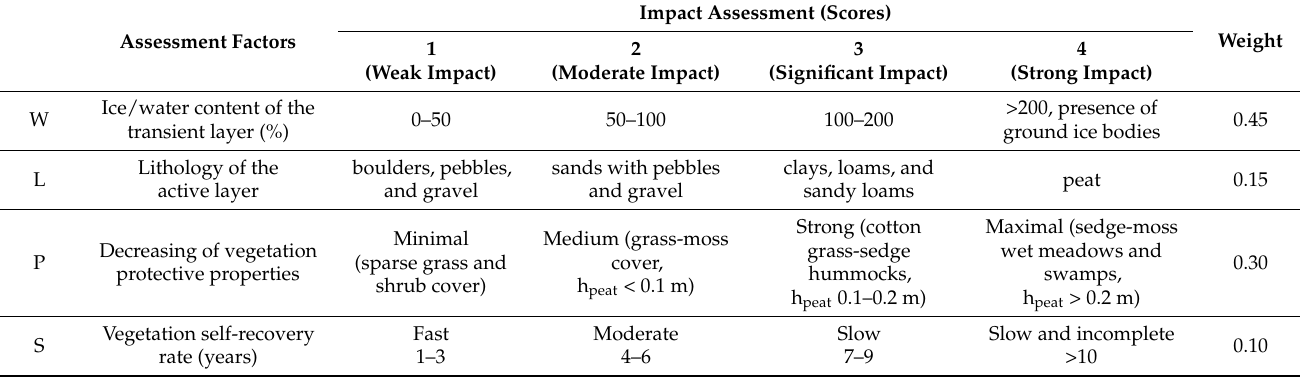
Table 1. Factors affecting exogenous processes activation for the Eastern Chukotka coastal